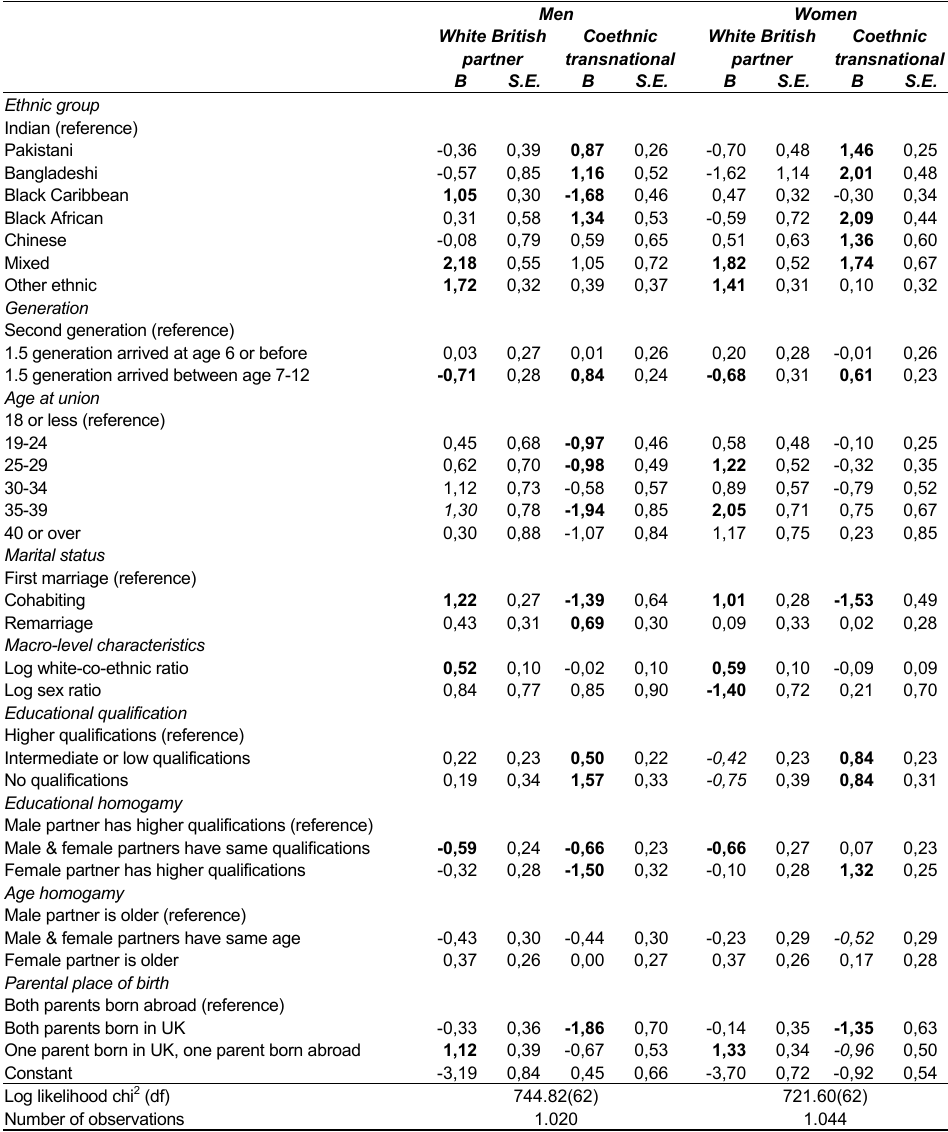
Men Women White British Coethnic White British Coethnic partner transnational partner transnational B S.E. B S.E. B S.E. B S.E.